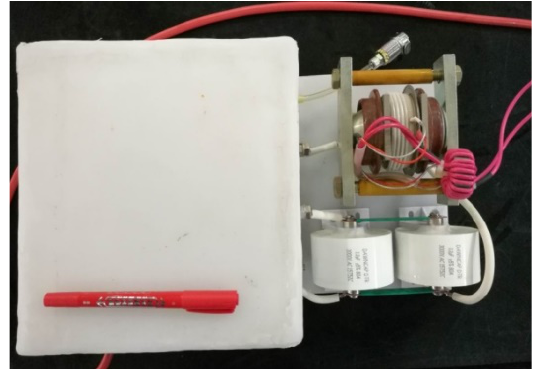
Figure 12. The photograph of the trigger source.